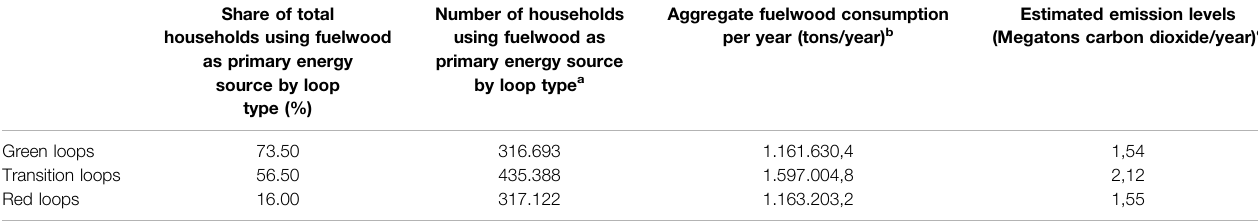
TABLE 4 | Estimate of annual fuelwood consumption in KwaZulu-Natal. Share of total households using fuelwood